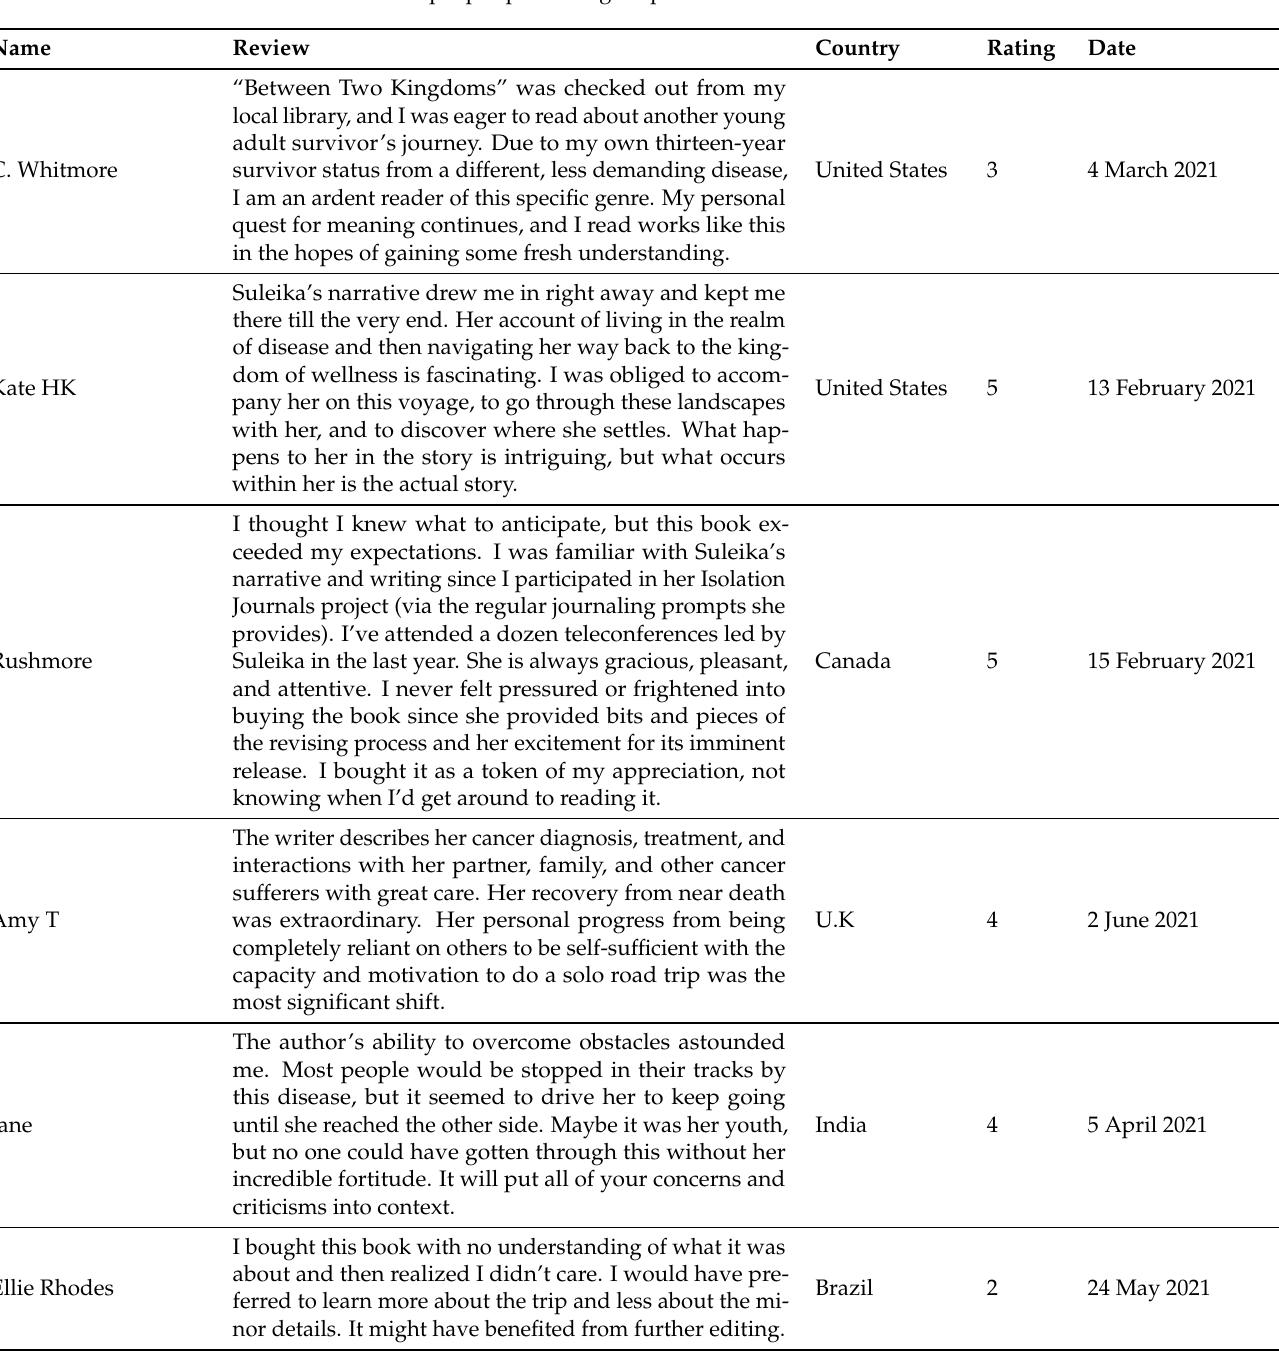
Table 2. Sample pre-processing